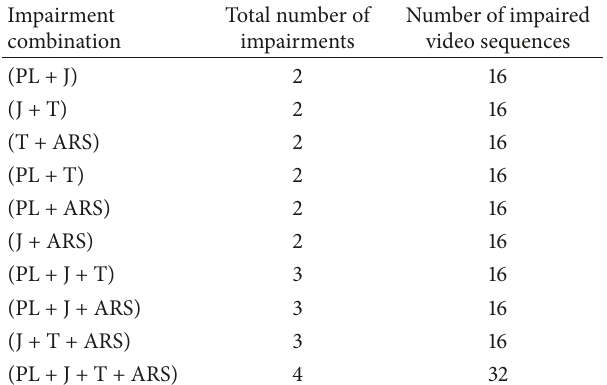
Figure 6: Breakdown of participants’ ages. Table 6: Impairment choice for 176 video sequences (network QoS).